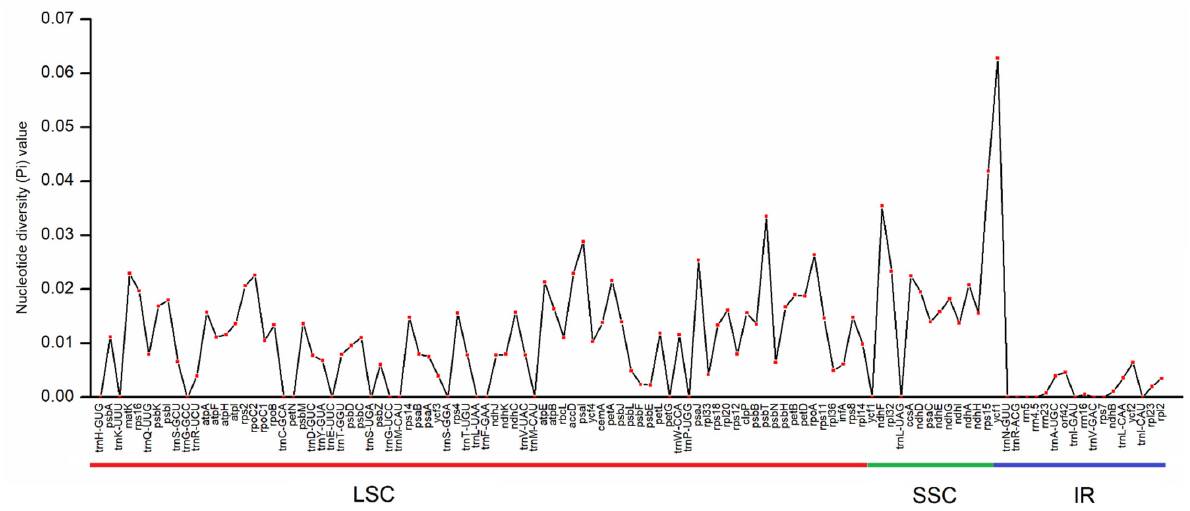
Figure 5. Nucleotide diversity of chloroplast genome of B. schreberi. The gene name and the area they existed are indicated in the X-axis, while the Pi value is shown in the Y-axis. The red point represent genes, and the location of points show the Pi value.